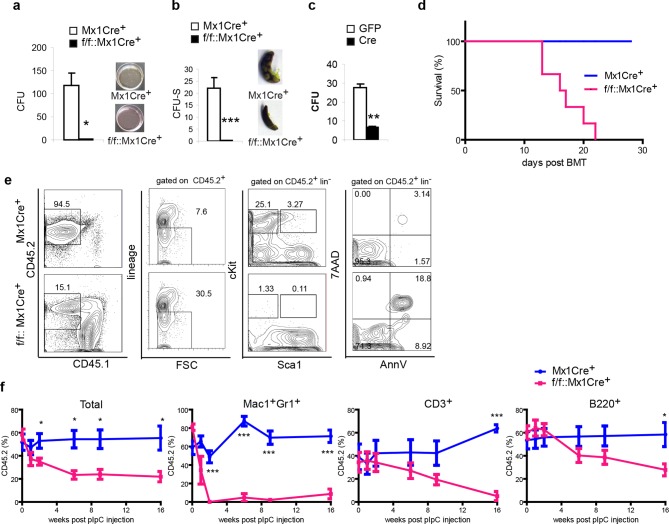
Ddb1 deletion impairs the differentiation of hematopoietic stem and progenitor cells.(a) Colony numbers and representative images from methylcellulose assay with bone marrow cells from polyI:C injected mice. (b) Colony numbers and representative images from CFU-S assay with bone marrow cells from polyI:C injected mice. (c) Bone marrow progenitor cells of Ddb1f/f::Mx1Cre+ mice were infected with retrovirus expressing either control GFP or Cre recombinase. Colony numbers were scored in methylcellulose assays. (d) Survival curve of recipient mice after bone marrow transplantation (n = 6 per group). Donor cells were from Ddb1f/f::Mx1Cre+ or control mice injected with polyI:C. (e) Representative FACS plots of bone marrow cells in recipient mice 7 days post Ddb1 deletion. Donor cells were from non polyI:C injected mice, and Ddb1 deletion was induced in recipient mice 8 weeks after engraftment. (f) Chimerism of peripheral blood in recipient mice (n=5 per group). Donor cells were a mixture at 50:50 ratios of wild type CD45.1+ cells and Ddb1f/f::Mx1Cre+ CD45.2+ cells (or control CD45.2+ cells). Ddb1 deletion was induced in recipient mice 8 weeks after engraftment. *p<0.05. **p<0.01. ***p<0.001DOI: